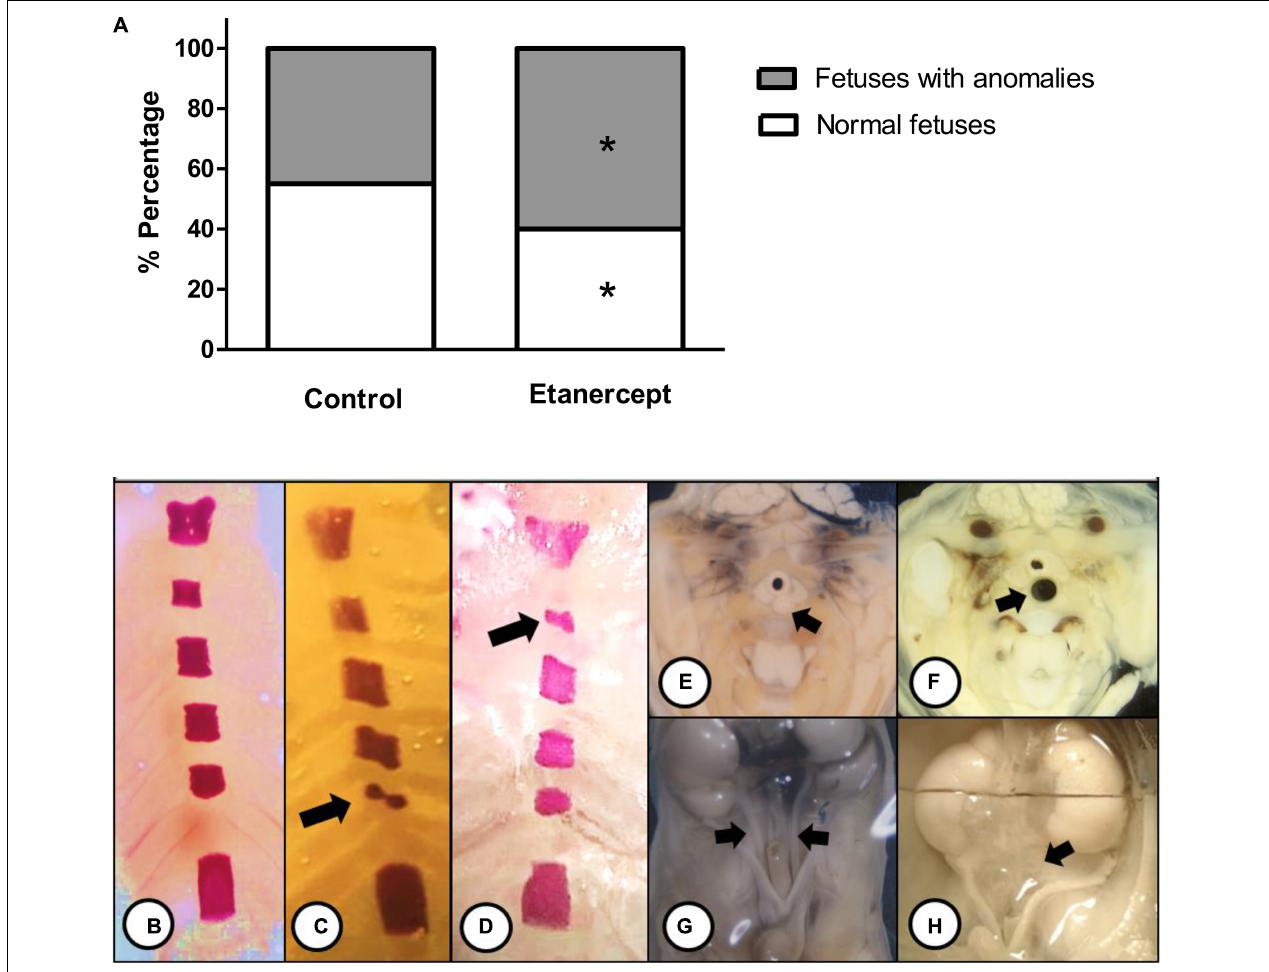
FIGURE 3 | (A) Percentage (%) of anomalies of fetuses from control and treated etanercept during pregnancy. Panels (B–H) representative images of the main skeletal (B–D) and visceral (E–H) anomalies. Panel (B) normal sternebra of rat fetuses. Panel (C) abnormally shaped sternebra (arrow). Panel (D) incomplete ossification of sternebra (arrow). Panels (E,F) a thoracic section from rat fetuses, with (E) normal trachea (arrow) and (F) dilated trachea (arrow). Panels (G,H) the pelvis section from rat fetuses, with (G) normal ureter (arrow) and (H) enlarged ureter—hydroureter (arrow). * p < 0.05 vs. control group (Fisher’s exact